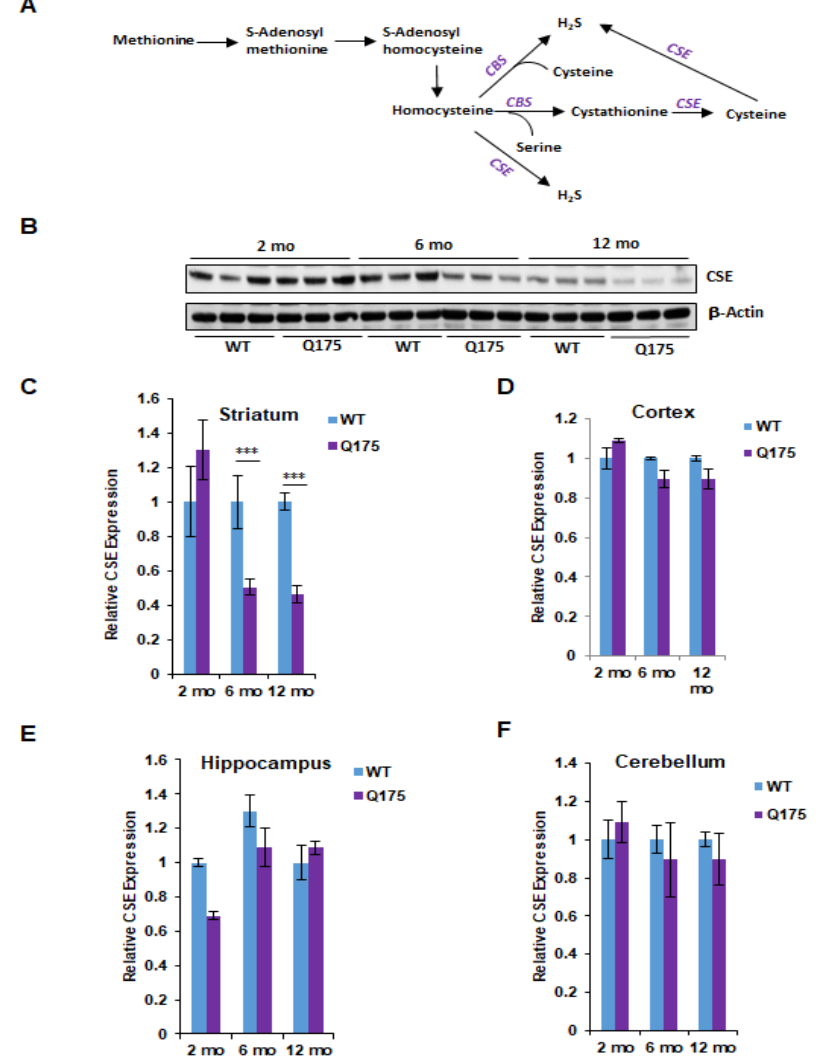
Figure 1. Expression of cystathionine γ -lyase (CSE) in the Q175 model of Huntington’s disease. ( A ) The transsulfuration pathway via which cysteine and hydrogen sulfide (H 2 S) is generated. Transsulfuration refers to the transfer of sulfur from homocysteine (which is derived from dietary methionine) to cysteine. Cystathionine β -synthase (CBS) condenses serine with homocysteine to generate cystathionine, which is acted on by CSE to produce cysteine. Cysteine and homocysteine serve as substrates of CSE or CBS to generate H 2 S. ( B ) Expression of CSE at 2, 6, and 12 months in the striatum, the region most profoundly affected in HD, in Q175 mice and their wild-type counterparts. ( C ) Quantification of B. ( D – F ) Expression of CSE at 2, 6, and 12 months in the cortex, hippocampus and cerebellum. n = 3, SEM. * ** p <